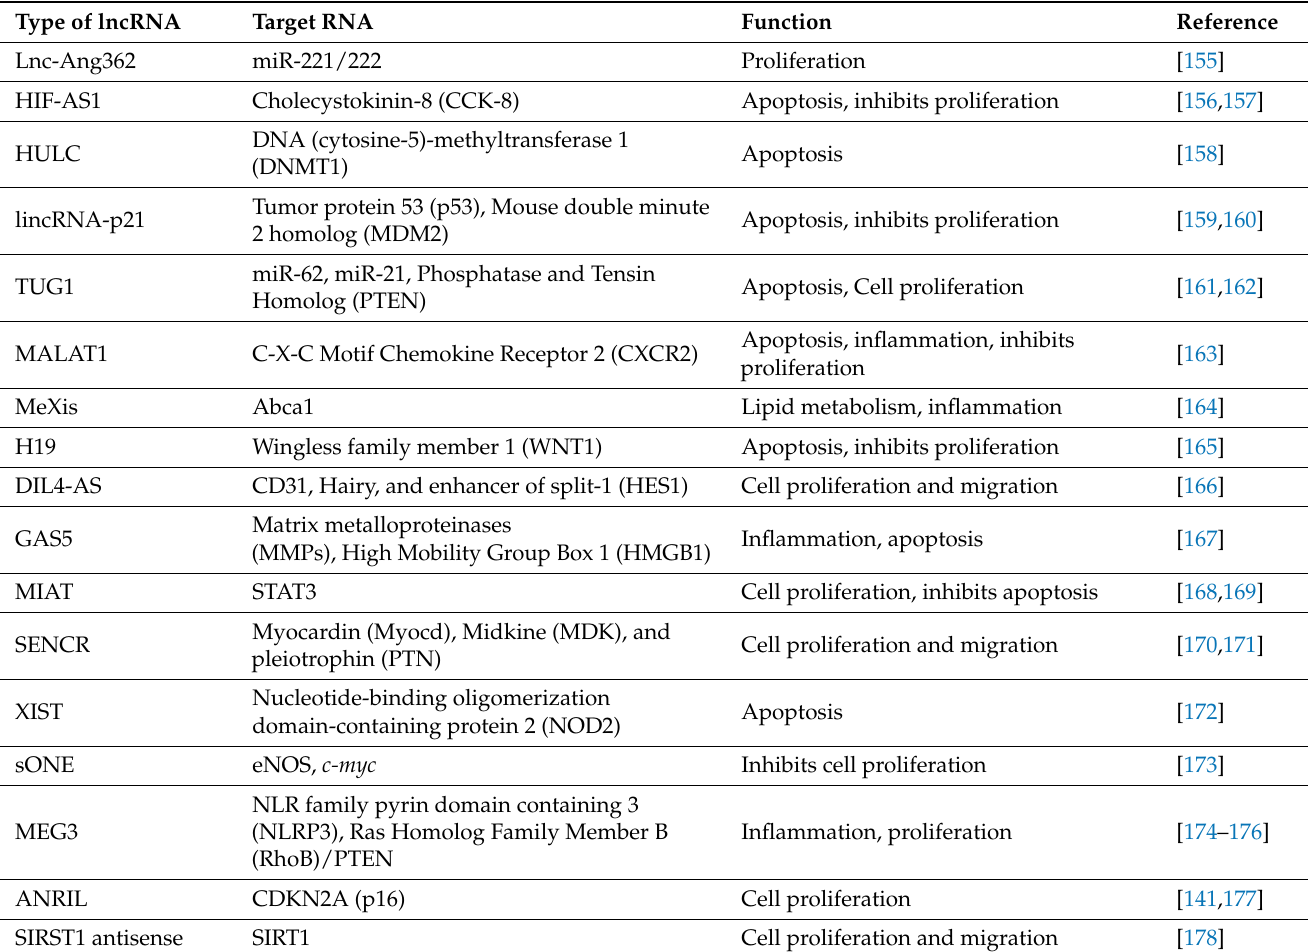
Table 3. Long noncoding RNAs, their targets, and